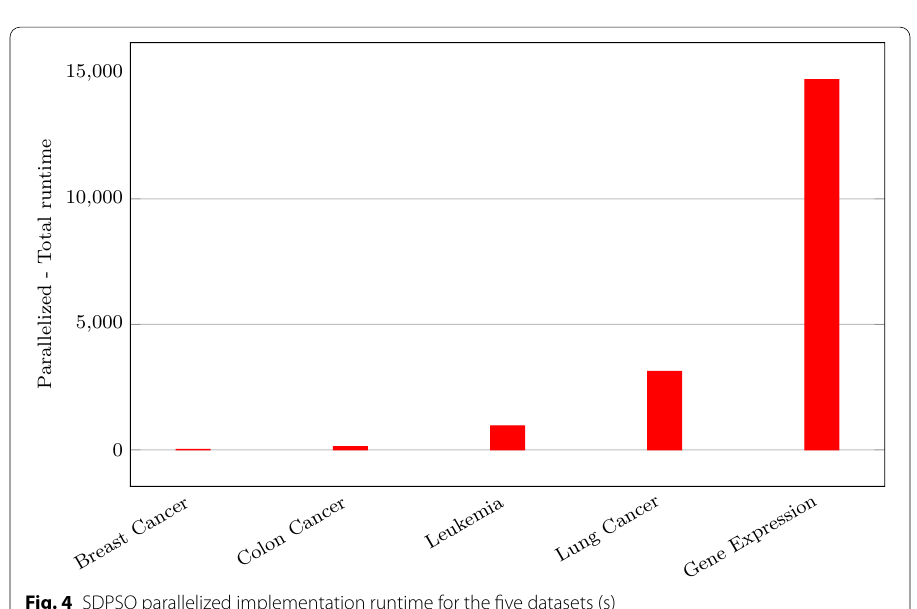
Fig. 4 SDPSO parallelized implementation runtime for the five datasets